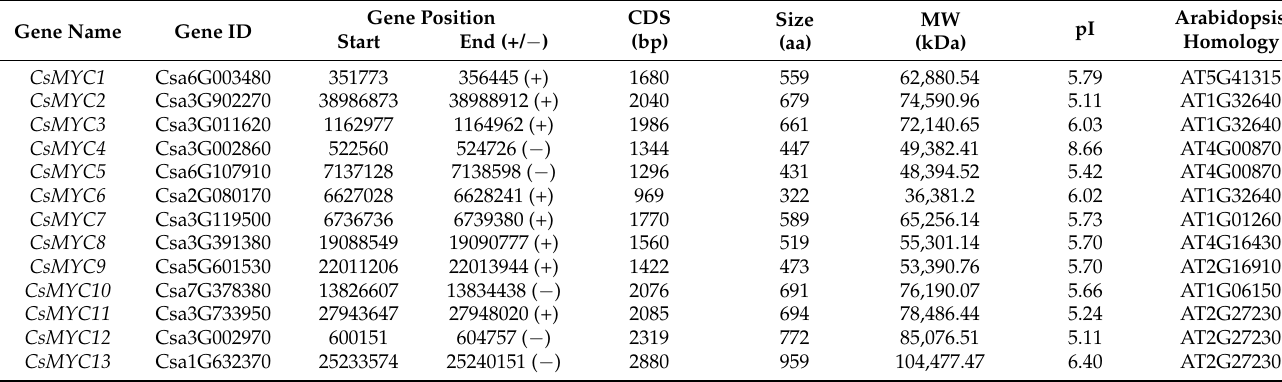
Table 1. Detailed information about 13 predicted cucumber MYC